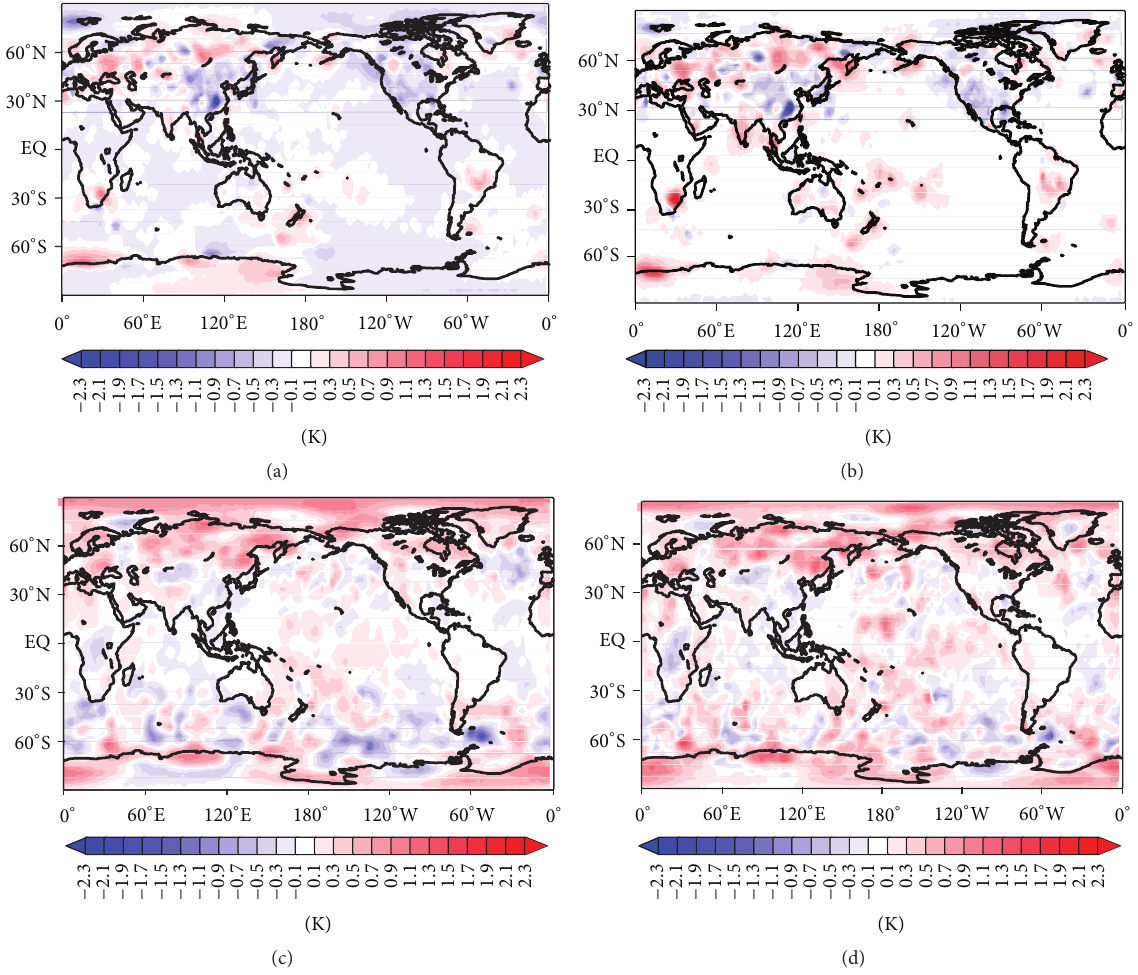
Figure 3: Geographical distribution of analysis increment (analysis minus background) for temperature at 500 hPa level at the first assimilation cycle for (a) GSI3DVar RAOB, (b) 3DEnsVar RAOB, (c) GSI3DVar AMSU, and (d) 3DEnsVar